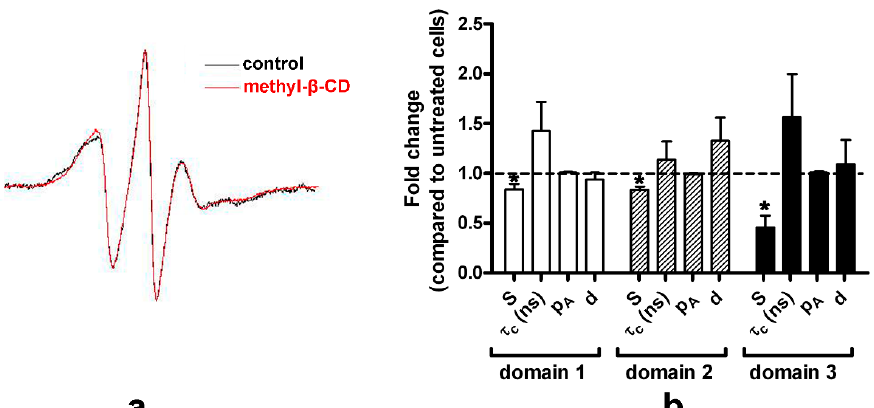
Figure 6. Effect of methyl- β -CD treatment on PM properties of the HEK-HAGnRH-R cell line. ( a ) Comparison of EPR spectra of the lipophilic spin probe MeFASL (10,3) in the PM of untreated (control; black line) and methyl- β -CD (10 mM, 60 min at 37 °C; red line) HEK-HAGnRH-R cells. The spectra shown are the sum of spectra from at least four independent experiments. ( b ) Order parameters (S), rotational correlation times ( τ c), polarity correction factor (pA), and the proportions (d) of the different domain types in HEK-HAGnRH-R cells. The parameters of the best fit of the calculated to the experi- mental spectra were obtained from GHOST diagrams. Results (mean ± S.E.) of four independent computer simulations are expressed as the relative change of each parameter obtained in cells treated with methyl- β -CD compared to untreated (control) HEK-HAGnRH-R cells * p < 0.05.